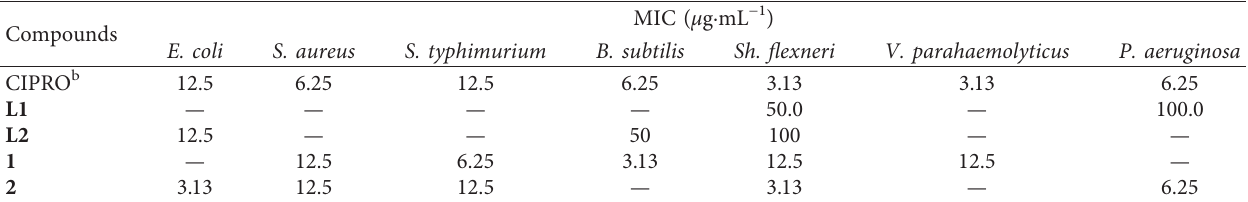
Table 9: Tests of MIC ( μ g/mL) of the ligands and complexes against bacterial strains a